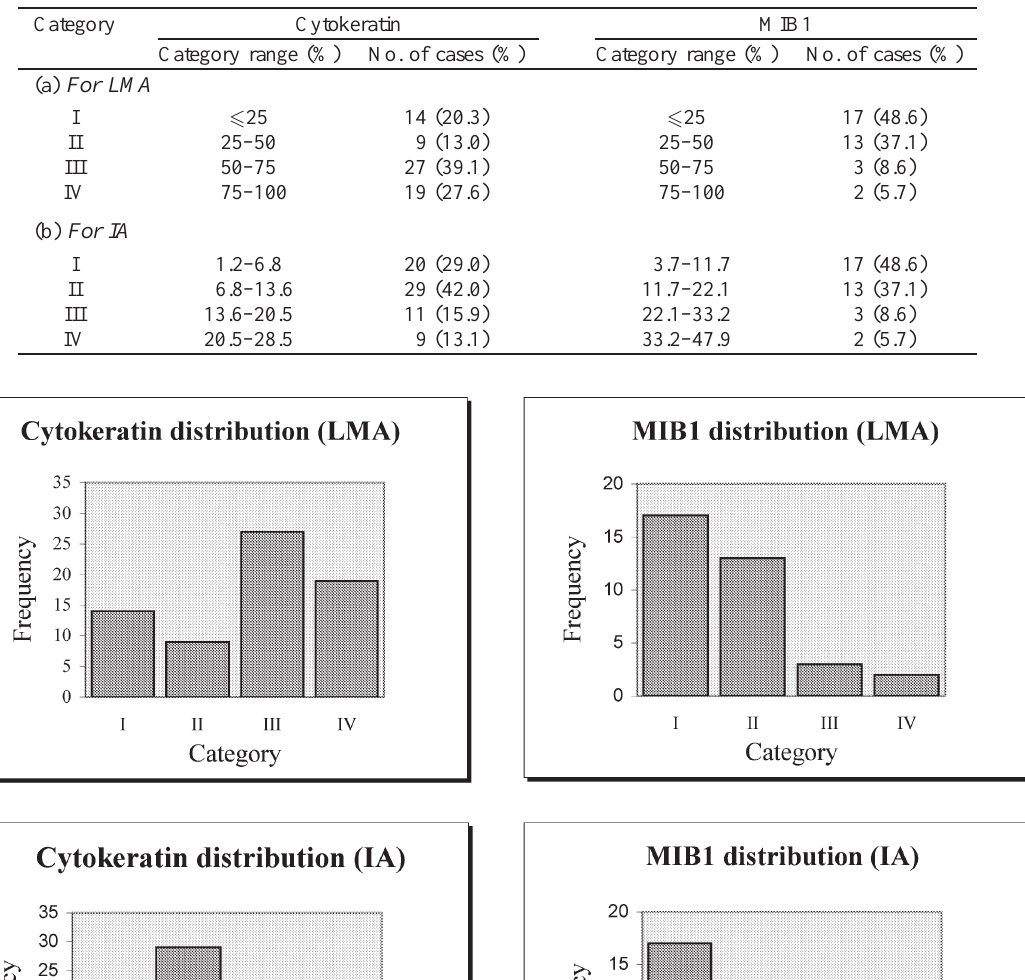
Table 2 Frequency distribution of cytokeratin and